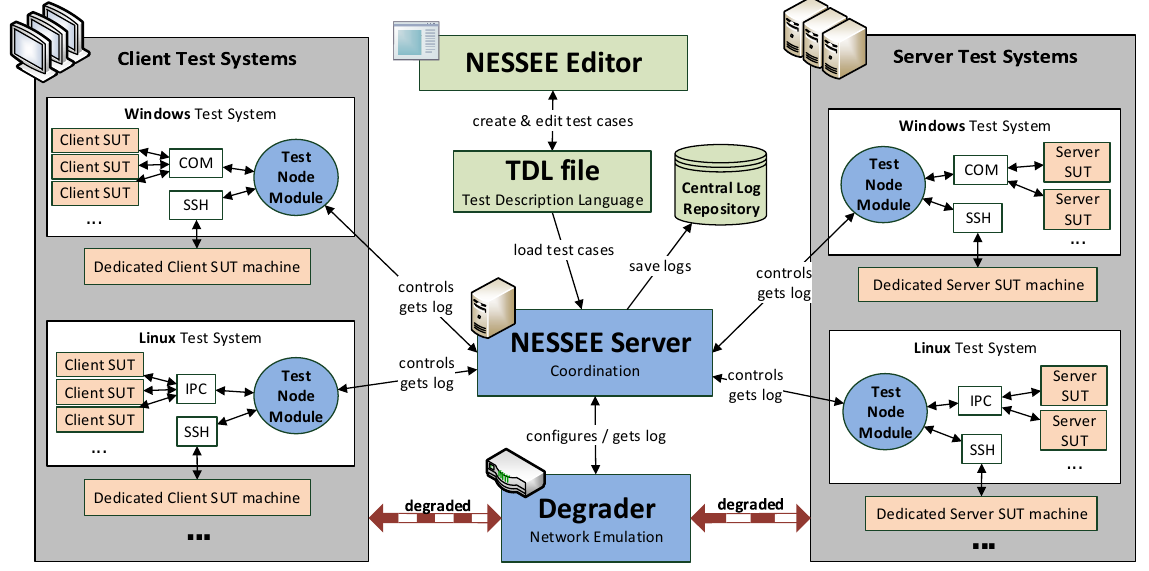
Figure 1: General architecture of the NESSEE platform (cf.